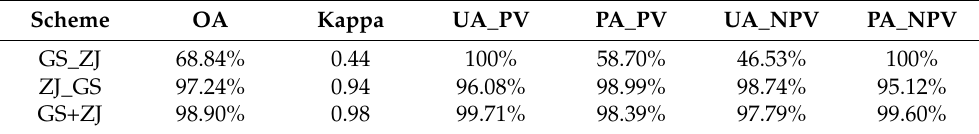
Table 6. Accuracy of different classification schemes.